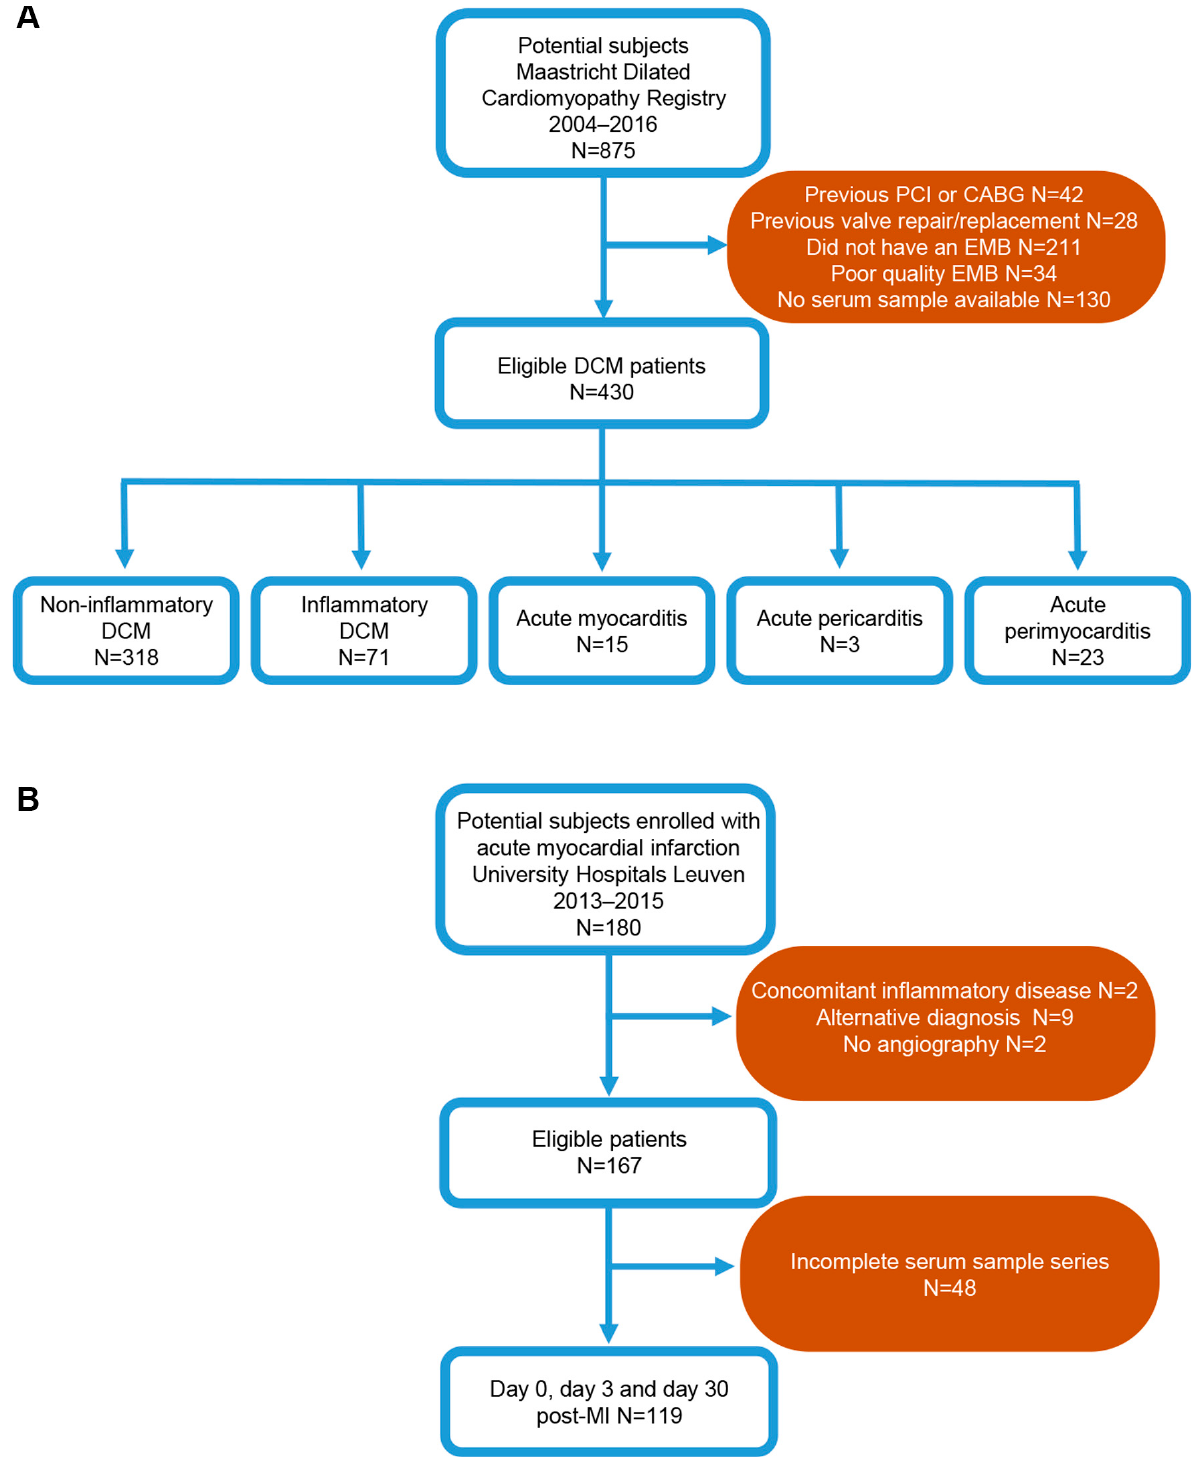
Figure 2. Flow diagrams of included patients. ( A ) Flow diagram of cardiomyopathy patients included from the Maastricht Dilated Cardiomyopathy Registry. ( B ) Flow diagram of patients with acute myocardial infarction (MI) enrolled at University Hospitals Leuven.